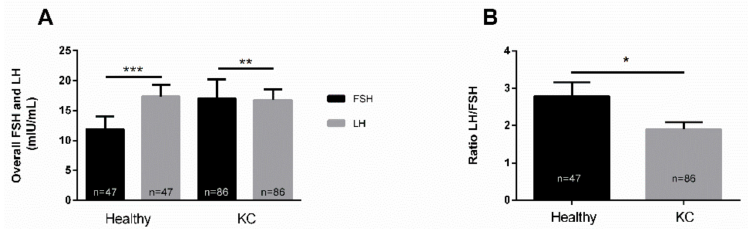
Figure 1. Expression of LH and FSH, and the LH / FSH ratio in healthy (n = 47) and KC (n = 86) blood (plasma) samples. ( A ) Overall levels for both LH and FSH, and ( B ) LH / FSH ratio in healthy controls and KCs. * p < 0.05, ** p < 0.01, *** p < 0.001. (See Supplementary Materials—Figure